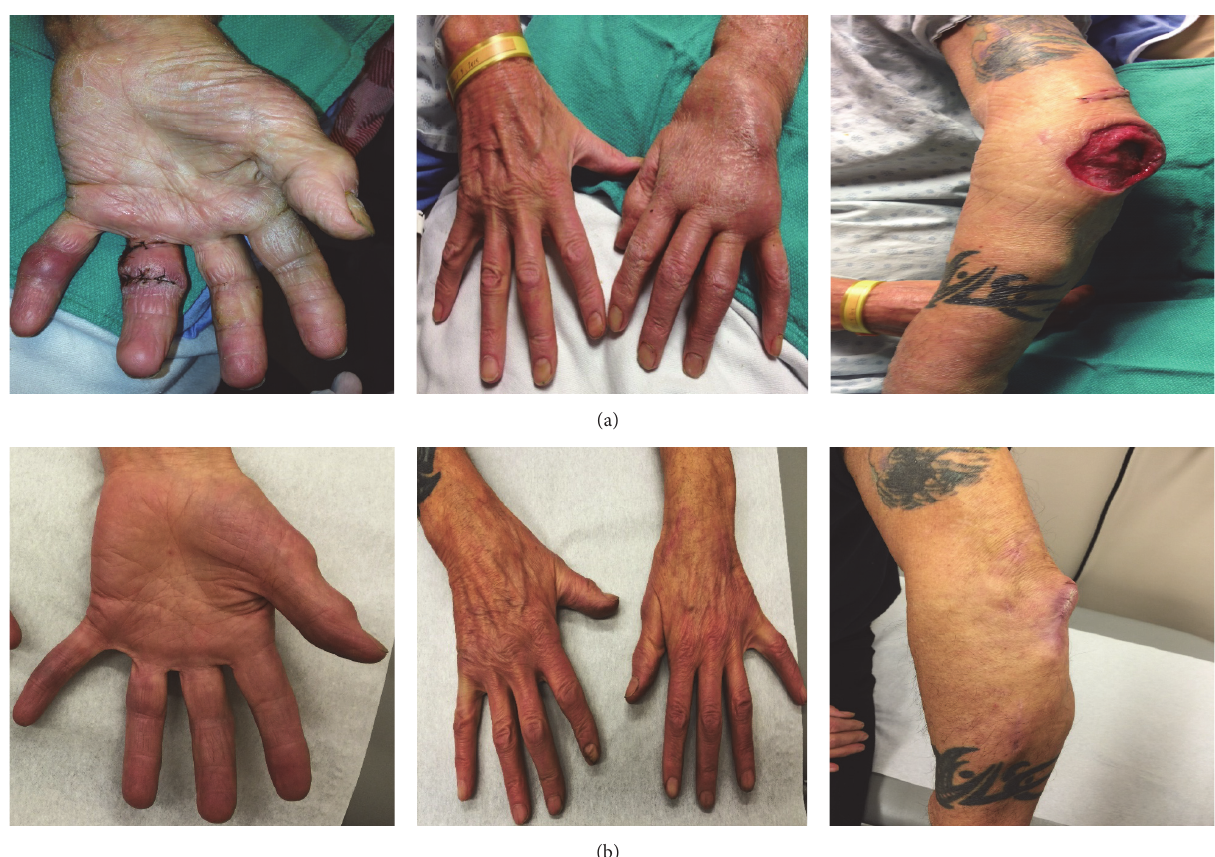
Figure 3: Pre- and postantibiotic therapy photos of lymphatic granulomatous disease from disseminated M. marinum infection. (a) preantimicrobial therapy and (b) posttherapy cure (left-to-right: palmar inflamed granulomas 4th/5th digits and resolution, dorsal lymphogranulomatous spread with soft tissue swelling of the left hand and corresponding resolution photo, surgical excision of left elbow granulomatous bursitis, and resolved inflammation with remnant